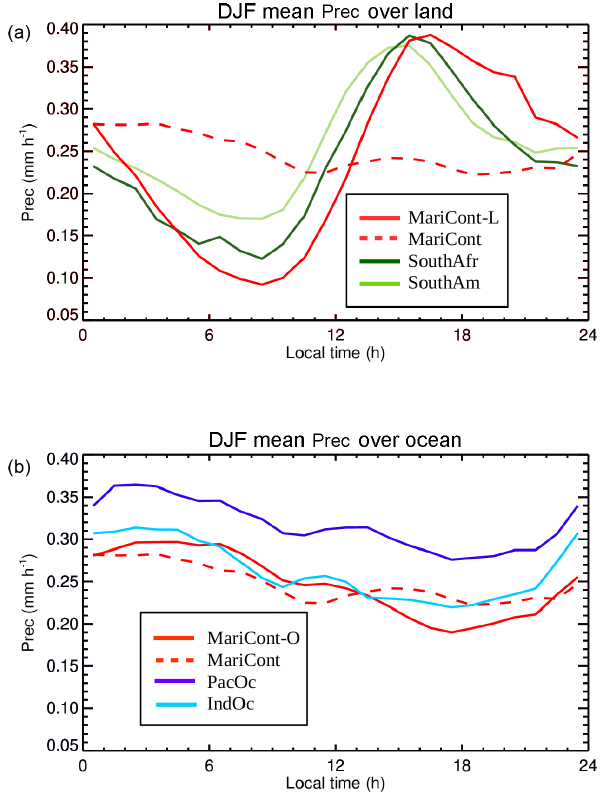
Figure 8. Diurnal cycle of precipitation (Prec) over (a) the land study zones and (b) the ocean study zones during the period DJF 2004–2017.